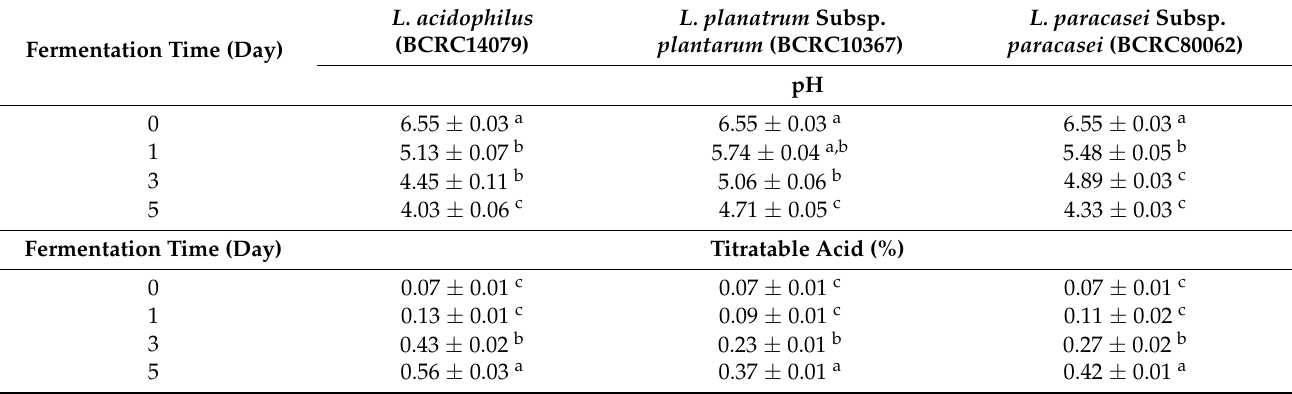
Figure 1. The fermented-process of mango peel by L. acidophilus (BCRC14079), L. plantarum subsp. plantarum (BCRC10367), and L. paracasei subsup. paracasei (BCRC80062). Table 1. The changes of pH and titratable acidity in fermented-mango peel (30%) by various lactic acid bacteria over the fermentation period.